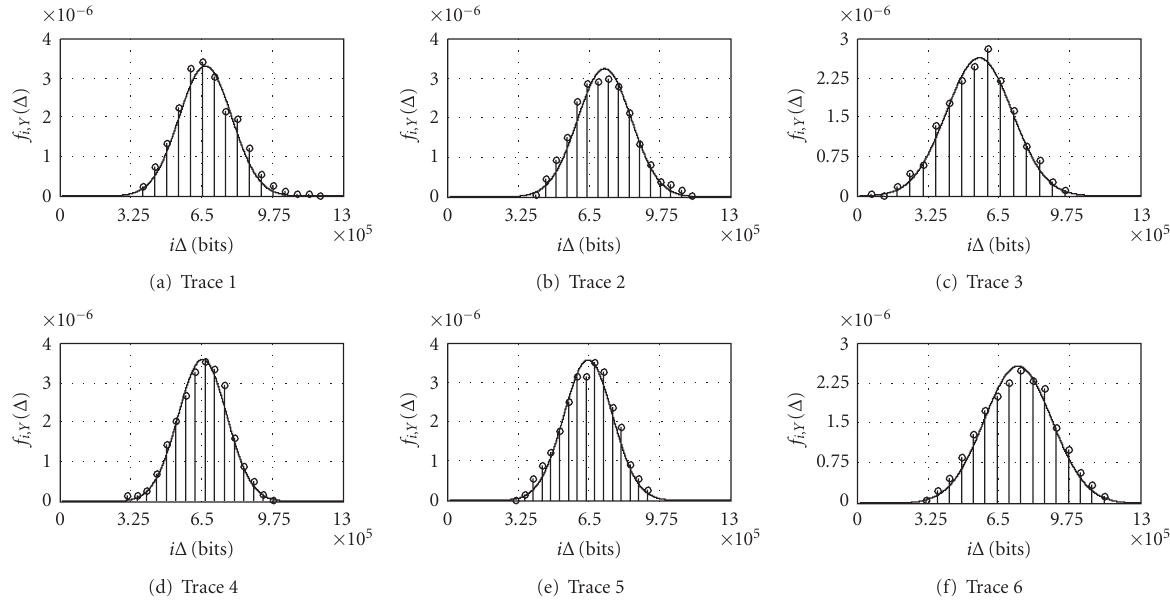
Figure 6: Histograms and their approximations by normal distribution.